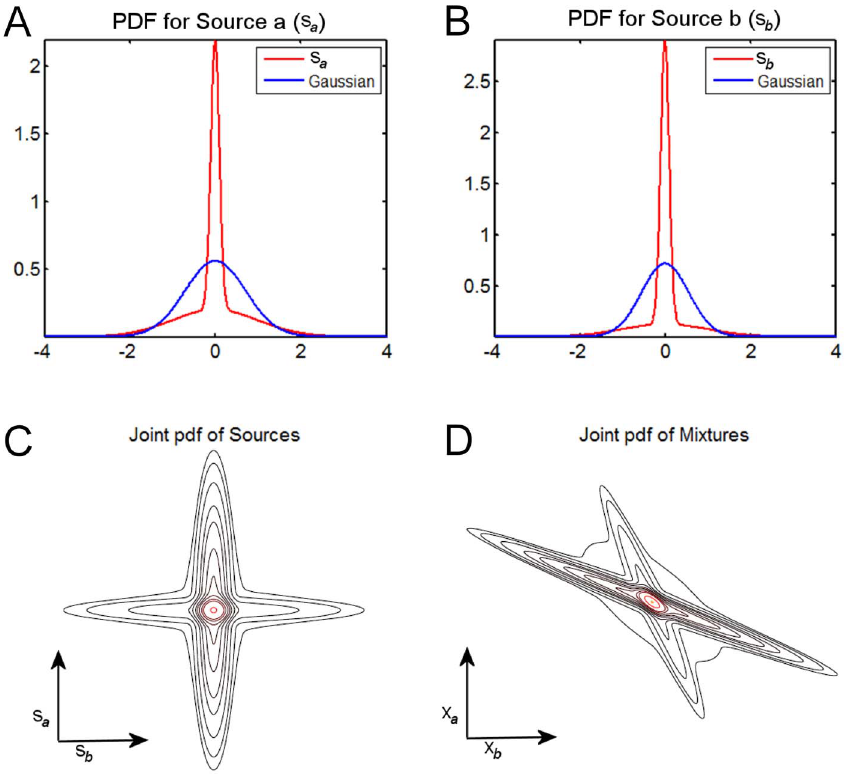
Figure 2. The distribution of sources and mixtures for l ~ 30% ( M 2 ). We plot (A–C) the distribution of sources, and (D) the contour plot of mixtures for the case of l ~ 30% ( M 2 ). Contrary to the claim made in Daubechies et al., the sources have in fact very peaky and heavy-tailed distributions and are not at all close to a Gaussian distribution. For comparison purposes we also present Gaussian distribution curves (blue, A–B).